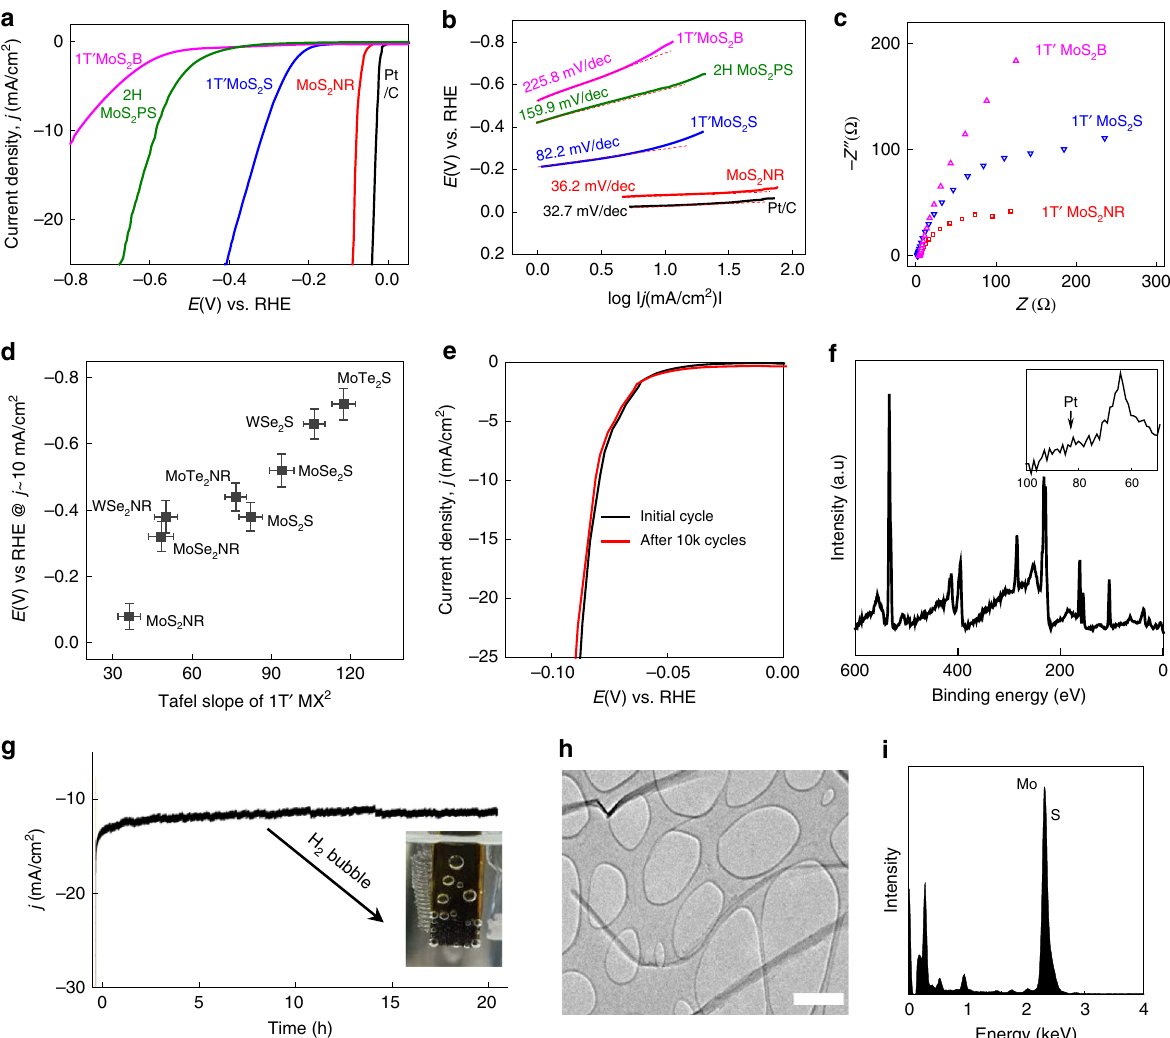
Fig. 4 HER electrocatalytic activity of MX 2 NRs. a Linear sweep voltammograms and ( b ) corresponding Tafel plots for MoS 2 NR, 1T ′ MoS 2 sheet (1 T ′ MoS 2 S), 2H MoS 2 porous sheets (2H MoS 2 PS) and bulk 1T ′ MoS 2 (1 T ′ MoS 2 B). Pt/C is included as reference. c Electrochemical impedance spectroscopy data for MoS 2 NR, 1T ′ MoS 2 S, and 1T ′ MoS 2 B. d Tafel slopes and required potentials to attain a current density of 10 mA/cm 2 for all unzipped 1T ′ MX 2 NRs, compared to exfoliated 1T ′ MX 2 S. e Polarization curves for MoS 2 NR before and after 10,000 CV scans. f XPS spectrum showing no Pt contamination during electrocatalytic cycling, inset is zoomed for 50 – 100 eV. g Chronoamperometric response of MoS 2 NR at an applied potential of 80 mV vs. RHE displaying variation of current density up to 20 h. Inset shows photograph of H 2 bubbling on the electrode surface ( h ) TEM of MoS 2 NR catalyst after10000 cycles. Scale bar, 0.5 µ m. i Associated EDS